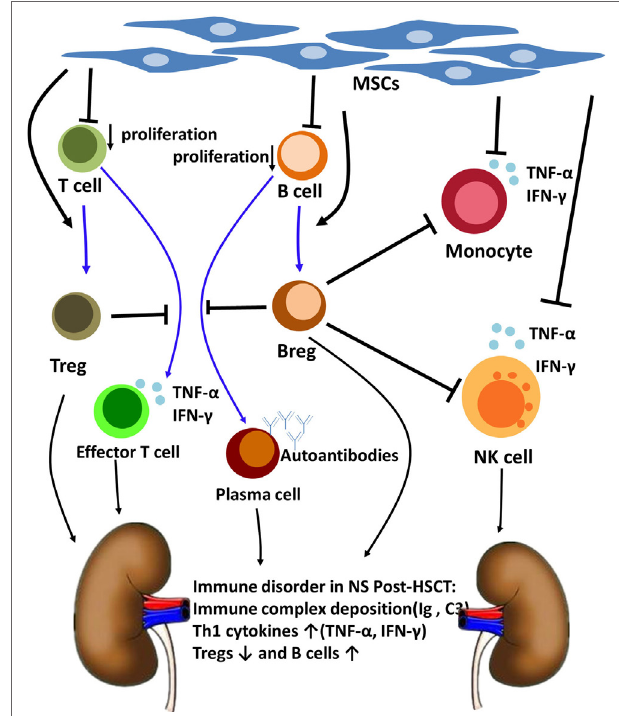
FIgURe 4 | The Nephrotic syndrome (NS) immune disorder after allogeneic hematopoietic stem cell transplantation (allo-HSCT) and the immunoregulatory mechanism of mesenchymal stem cells (MSCs) and regulatory B cells (Bregs). NS post-HSCT is an immune disorder involves immune complex deposition, B cells, regulatory T cells (Tregs) and Th1 cytokines. MSCs can modulate NS after allo-HSCT by suppressing B cell proliferation, inducting Tregs and Bregs, and inhibiting inflammatory cytokines production by monocytes and NK cells. Breg cells have been considered to be central to the maintenance of immune tolerance. Bregs suppress effector T cell differentiation, support Tregs differentiation, and suppress TNF- α production by monocytes and NK cells. Bregs also suppress B cells maturation into antibody-producing plasma